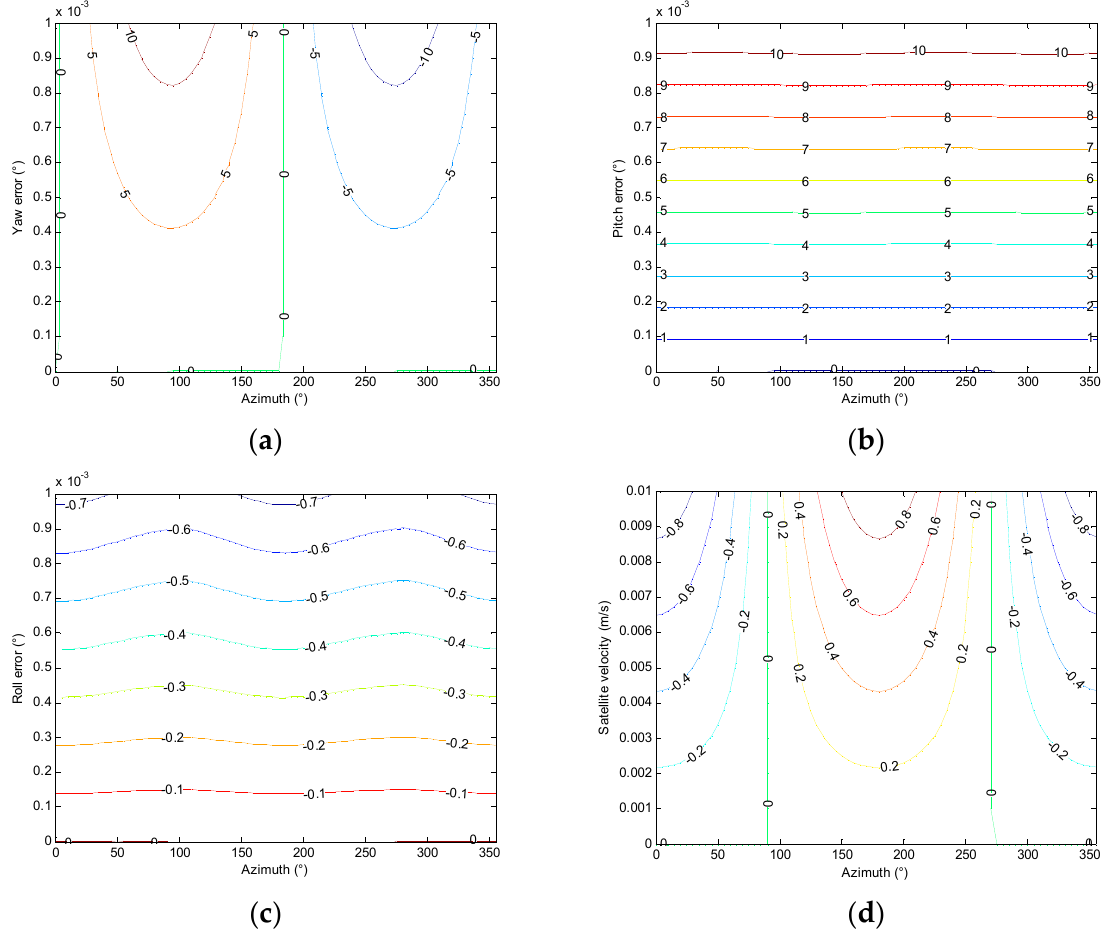
Figure 23. Satellite attitude and velocity determinations effects on current retrieval: ( a ) yaw; ( b ) pitch;